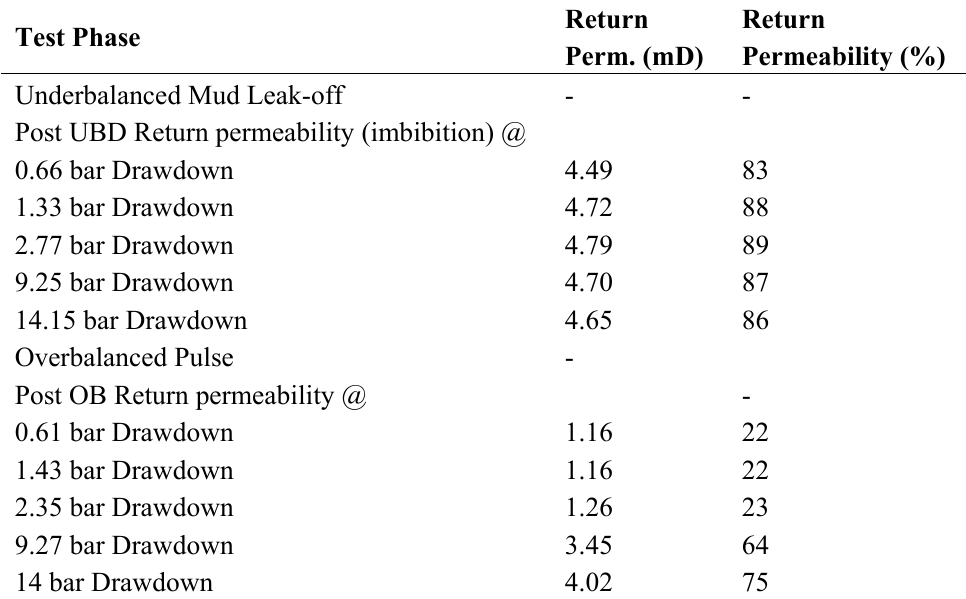
Table 7. UBD leak-off test with water-based; Sample C, Permeability Summary.